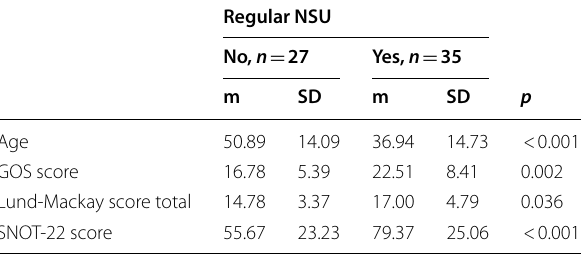
Table 2 Mean and standard (m parameters according to regular nasal steroid use